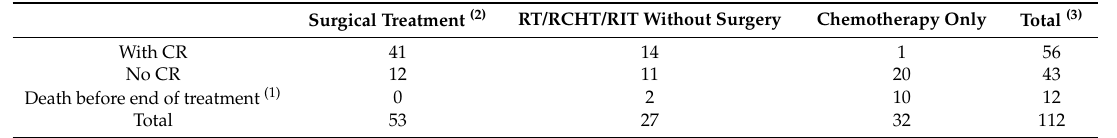
Table 4. Complete response (CR) rates to second-line treatment in 112 patients with persistent HNC following first-line treatment depending on second-line treatment modality. (RT: Radiotherapy, RCHT: Radiochemotherapy, RIT: